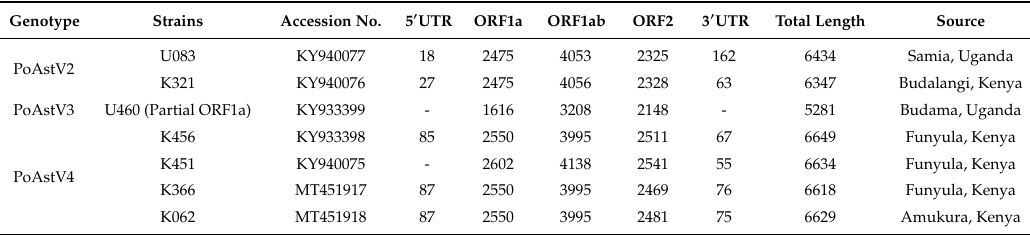
Table 1. Comparison of the genomic organization of porcine astroviruses circulating in smallholder swine farms in East